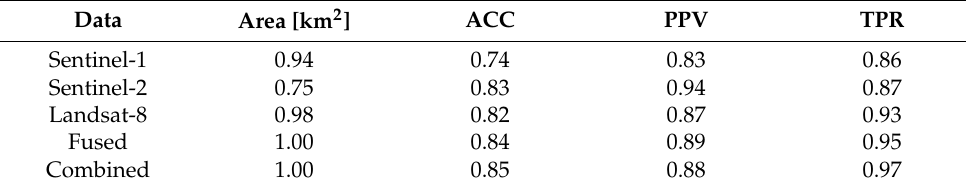
Table 4. Satellite dataset used for the 2014–2015 Fogo eruption. Mission